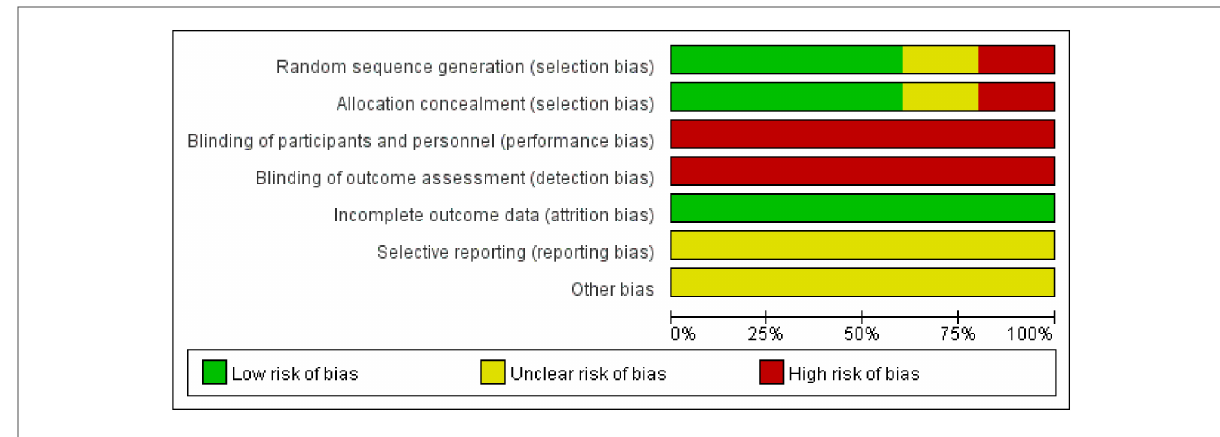
FIGURE 2 Map for the risk of bias: review the author ’ s decision on the risk of bias items, expressed as a percentage of all the included articles.